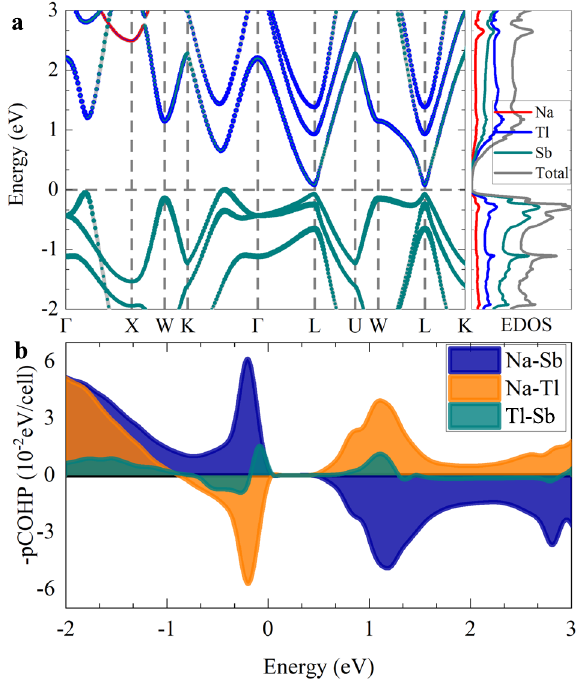
Fig. 5 Electron structure. a The projected electronic structure and partial electronic density of states for Na 2 TlSb using the PBEsol